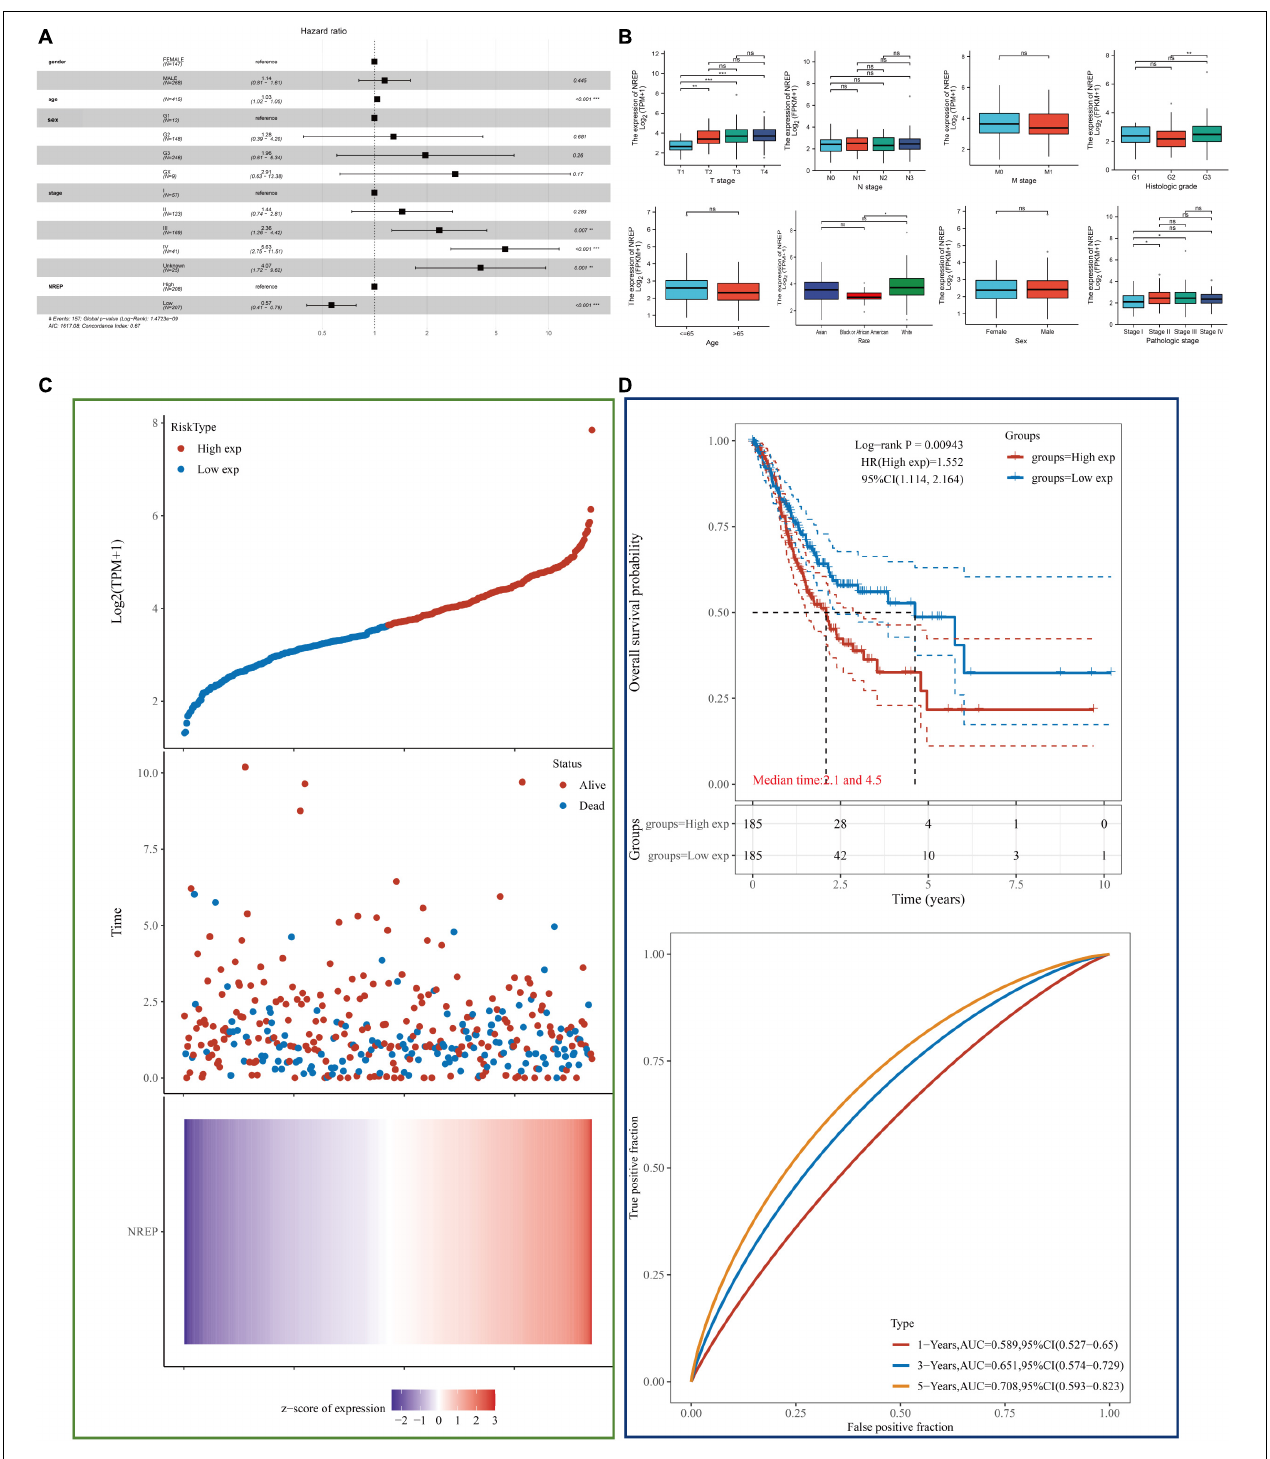
FIGURE 2 | Diagnostic value of NREP expression in gastric cancer (GC) based on clinical characteristics. (A) Forest plot showing data on Sex, Age, tumor Grade/Stage, and NREP expression. (B) Association of NREP mRNA expression with T/N/M stage, histologic grade, pathologic stage, sex, race, and age in GC patients. (C) Patients were divided into low- and high-risk groups according to the median NREP expression. From top to bottom: The curve of risk score. Survival status of the patients and more dead patients corresponding to the higher risk score. Heatmap of NREP expression. The horizontal coordinates all represent samples, and the samples are ordered consistently. (D) Kaplan–Meier survival analysis and time-dependent receiver operating characteristic analysis based on NREP levels. (ns: no significance, * P < 0.05, ** P < 0.01, *** P < 0.001).